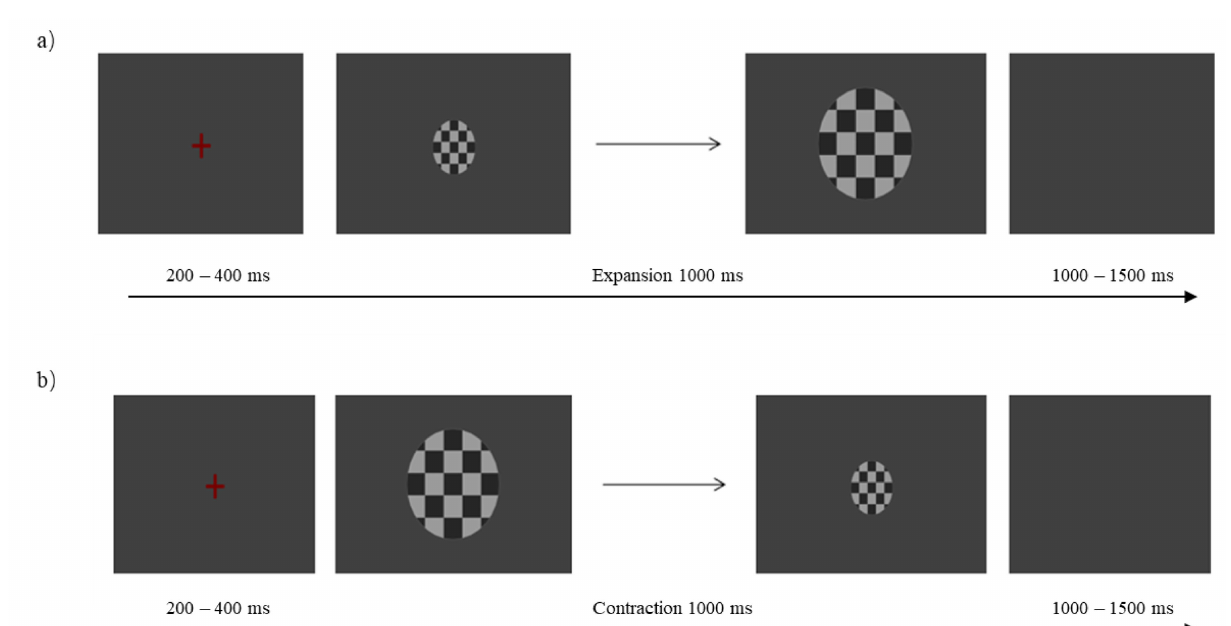
Figure 2. Schematic diagram of the experimental procedure of the expansion ( a ) and contraction ( b ) processes. There was no need for participants to